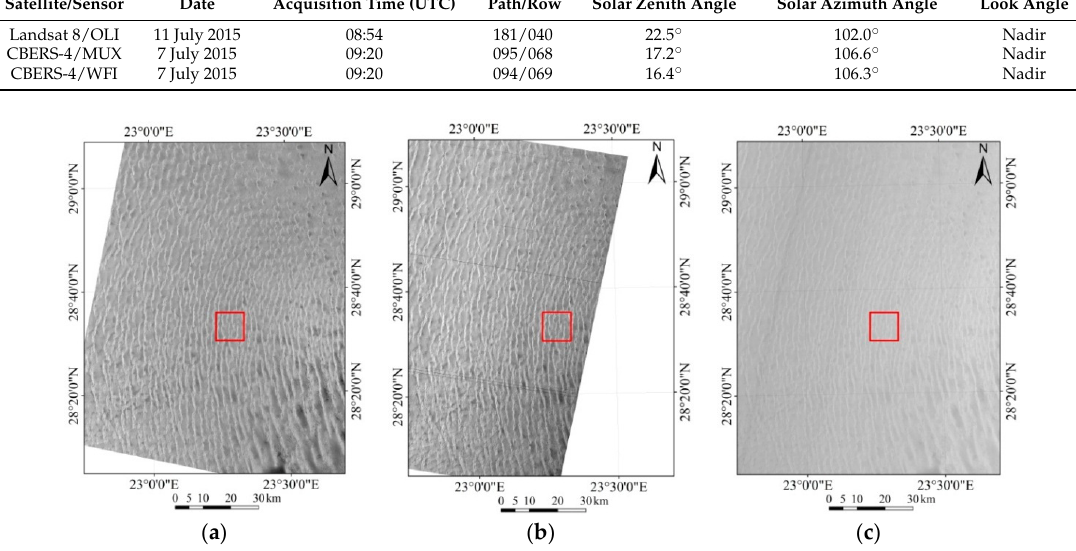
Figure 4. Libya-4 image from ( a ) Landsat-8/OLI ( b ) CBERS-4/MUX and ( c ) CBERS-4/WFI. The red box indicates the location of the study area.